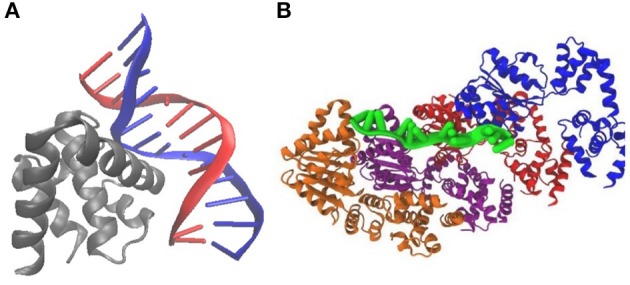
Crystal structures of DnaA binding to E. coli DNA suggest a mechanism for initiation of replication: (A) PDB 1J1V; DnaA(IV) binds to a 9-bp signature on dsDNA. (B) PDB 3R8F; Four DnaA(III) bind to 3-nucleotide increments on ssDNA.